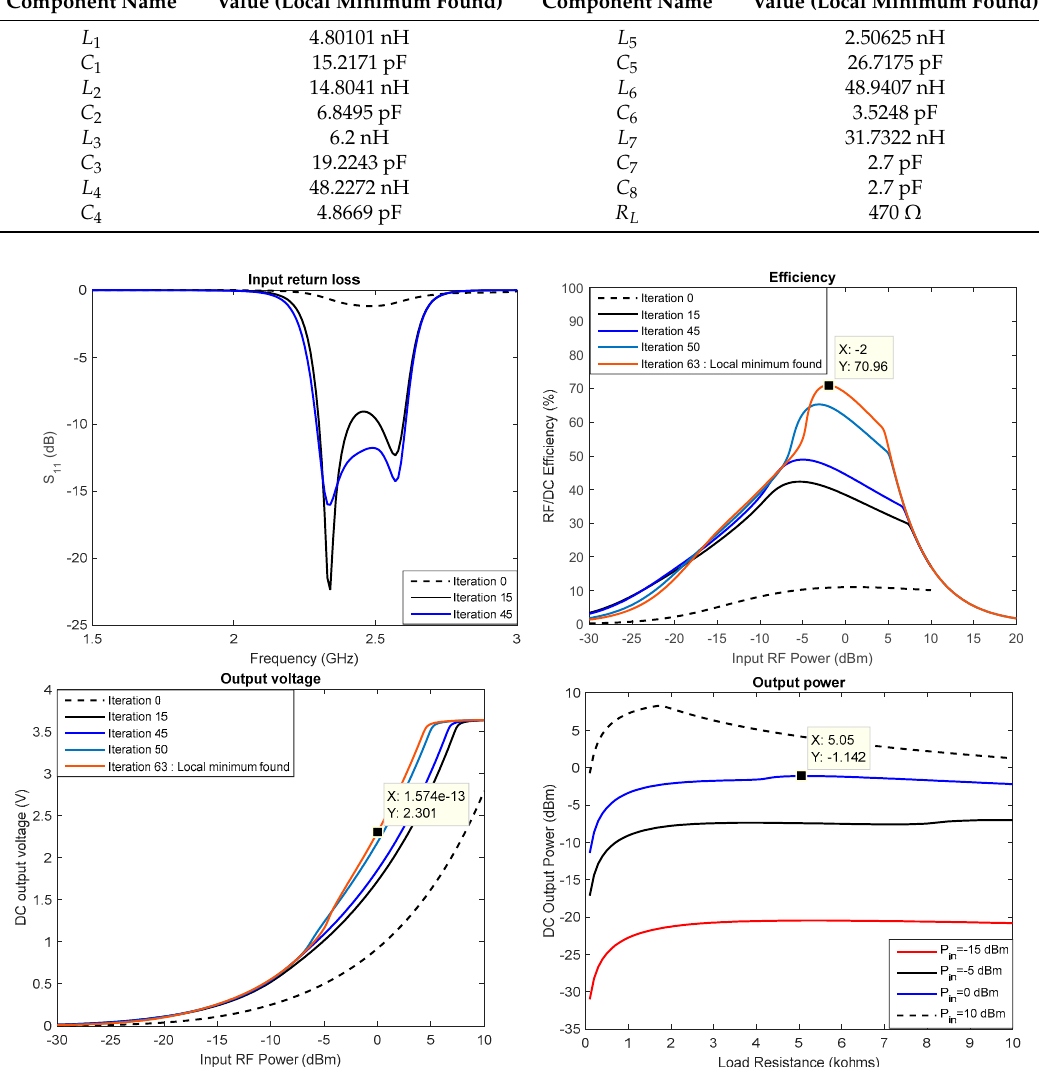
Table 5. Components values for Figure 18.